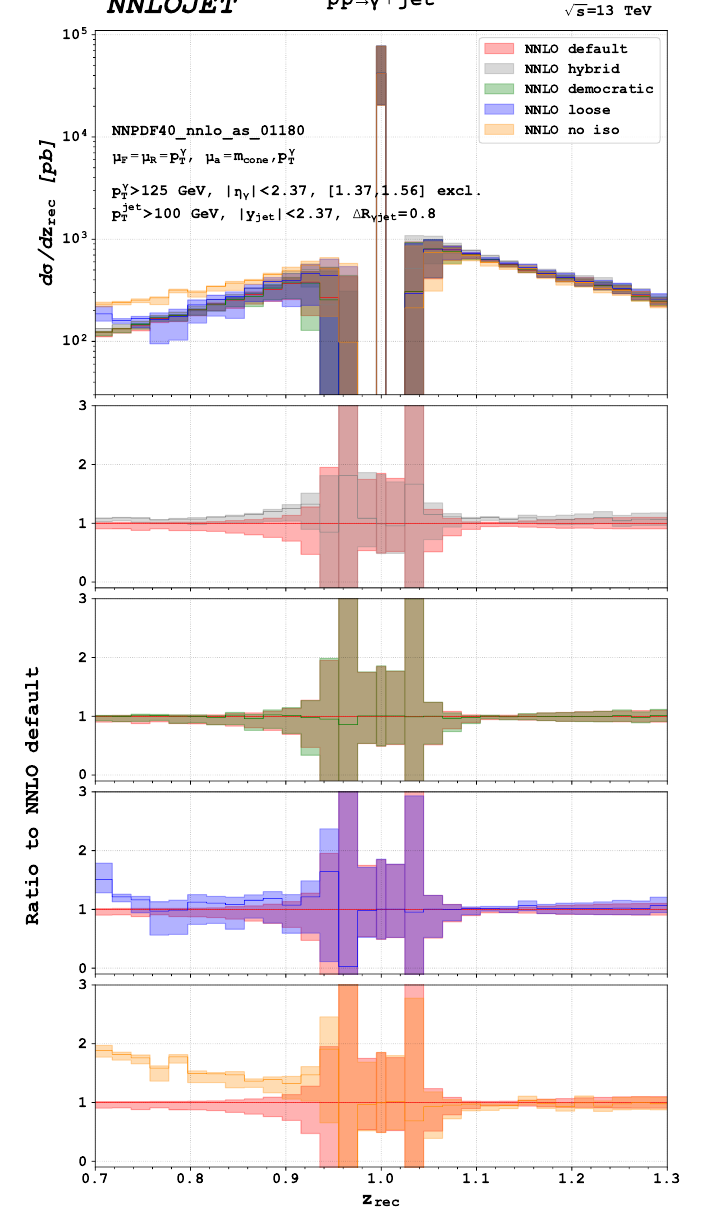
Figure 19. Predictions for the photon-plus-jet cross section differential in z rec using different isolation